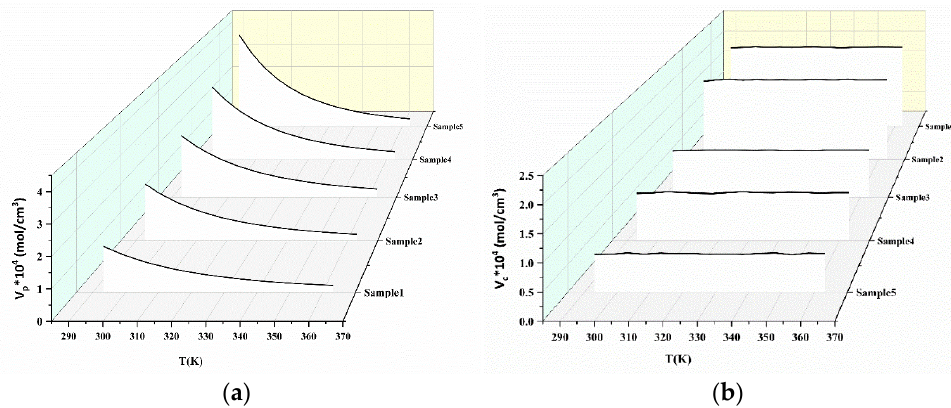
Figure 10. Variation of physical crosslinking density ( a ), chemical crosslinking density ( b ) with tem- perature for pseudo-semi IPNs. Table 3. Correlation coefficients as well as V c and V p constants obtained by experiments and theo- retical calculation.